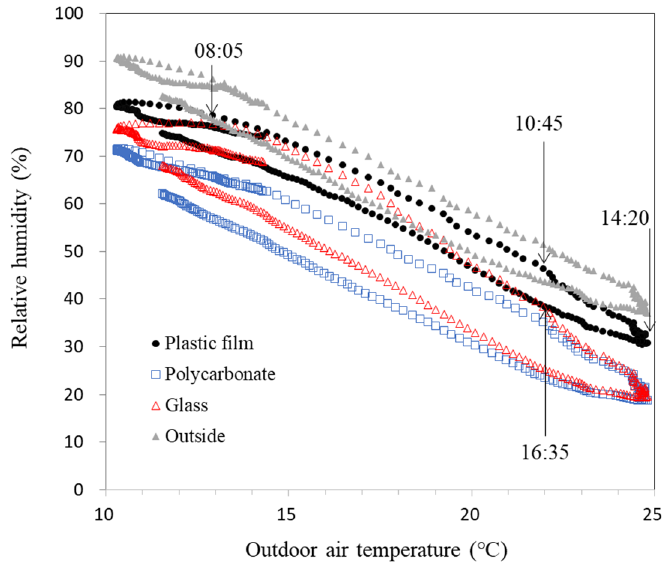
Figure 12. Comparison of relative humidity as a function of outdoor air temperatures in greenhouses covered with different covering materials (12–13, 19–20, and 26–27 October 2019).